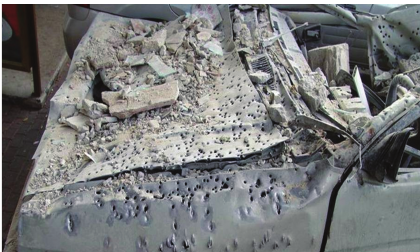
F1:Acaraer�reofshrapnelormultiplepelletsstoredinlong range missiles demonstrating the density and destruction. Imagine what would be the result in a human body.